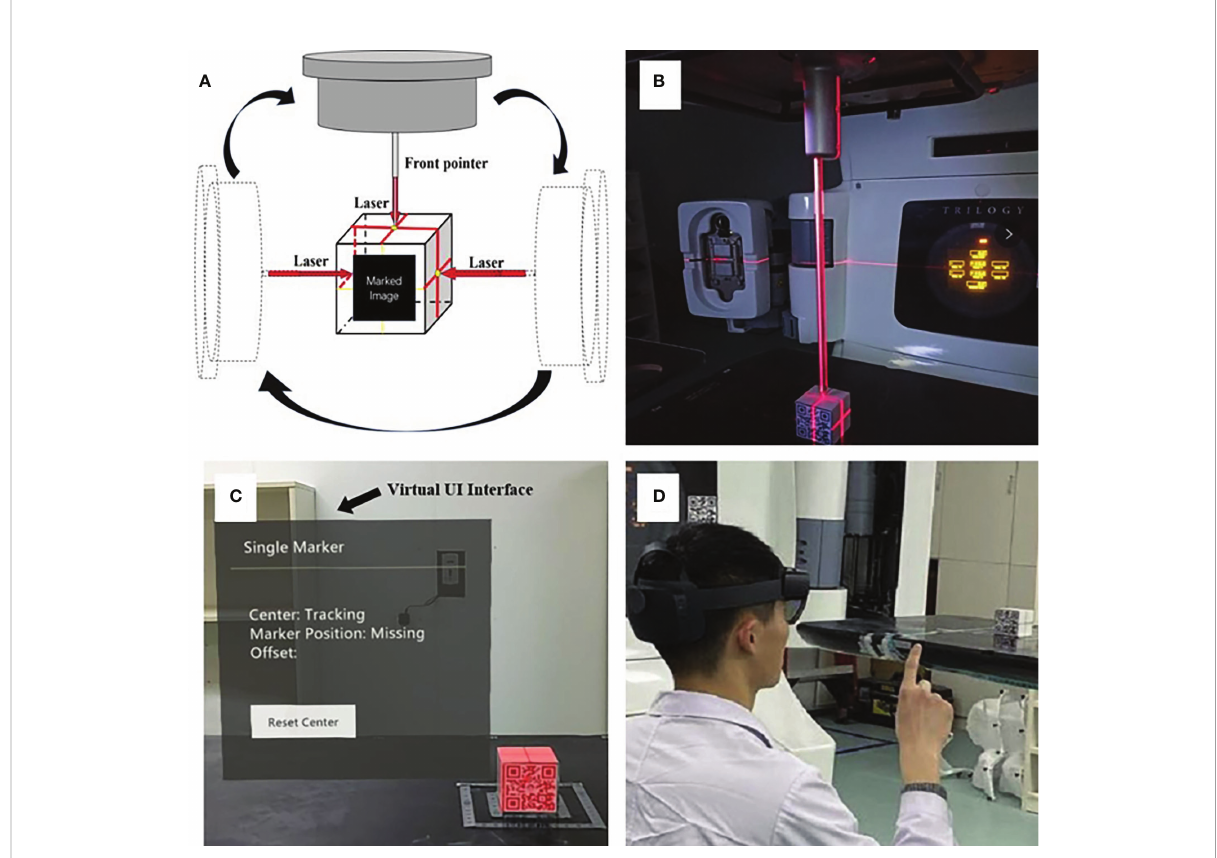
FIGURE 3 The establishment of the correlation between virtual and real space: precise placement of the “ ISO cube ” in the isocentric position with the aid of lasers and the mechanical front-pointer (A, B) ; automatic registration of virtual “ ISO cube ” and real “ ISO cube ” based on the HoloLens 2 ’ s detection of Vuforia marker, and the arrow points to the virtual UI interface (C) ; the gesture interaction to anchor the correlation between virtual and real space (D)